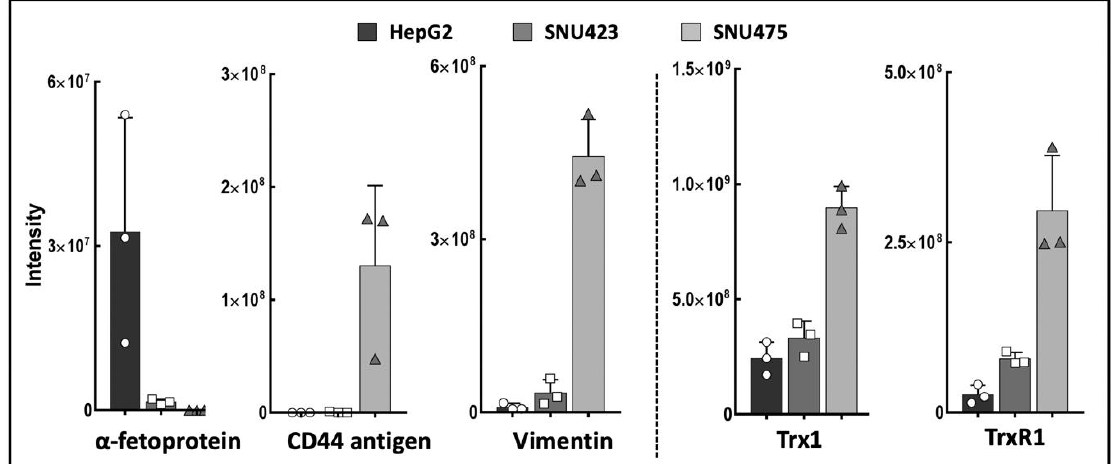
Figure 1. Epithelial–mesenchymal transition (EMT) markers and thioredoxin system in three hepatocarcinoma (HCC) cells lines. Data for vimentin, alpha-fetoprotein, CD44 antigen, Trx1, and TrxR1 were retrieved from the quantitative proteomic analysis of HepG2, SNU423, and SNU475 cells (Supplementary File S1). The scale in the vertical axis is the relative intensity from the LC–MS / MS quantitative analysis and varies between proteins; the maximum value for each protein ranges from 3.25e + 007 for alpha-fetoprotein in HepG2 cells to 8.97e + 008 for Trx1 in SNU475 cells. ( N = 3, individual values are shown).